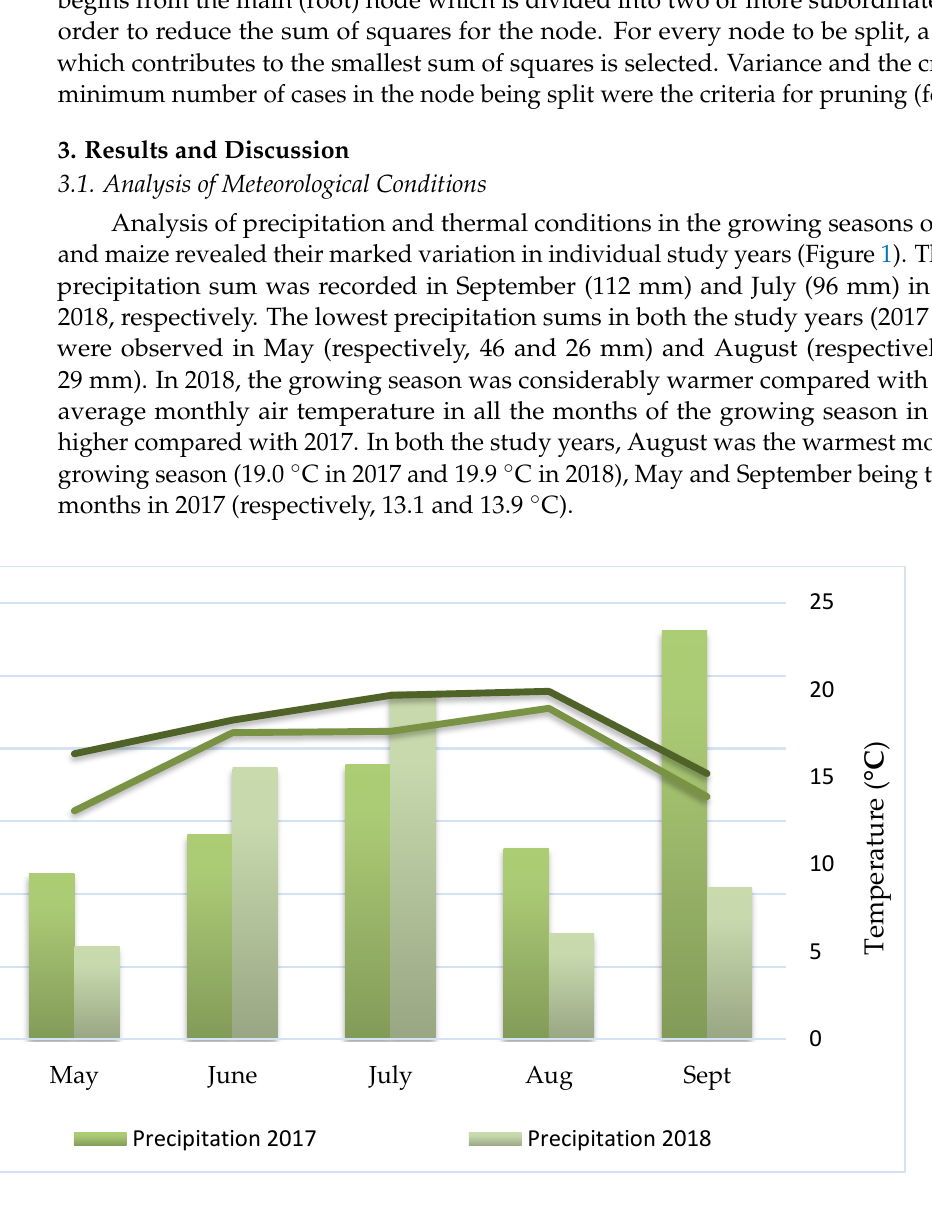
Figure 1. Air temperature and atmospheric precipitation values in 2017 and 2018.